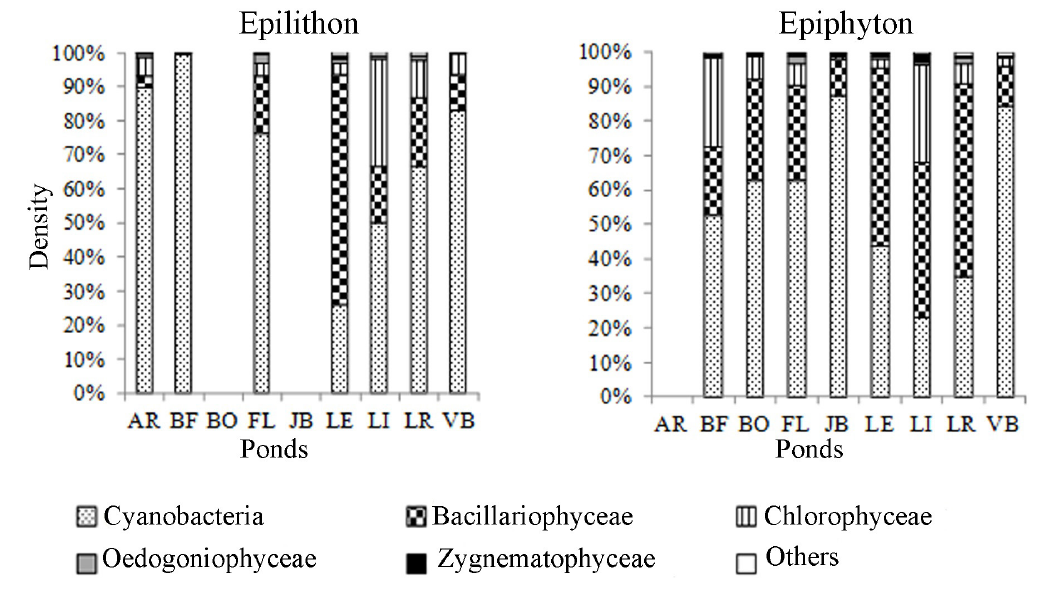
Figure 4. Relative density (%) of periphytic taxonomic classes in nine urban eutrophic ponds from Goiânia, GO (see codes at Table